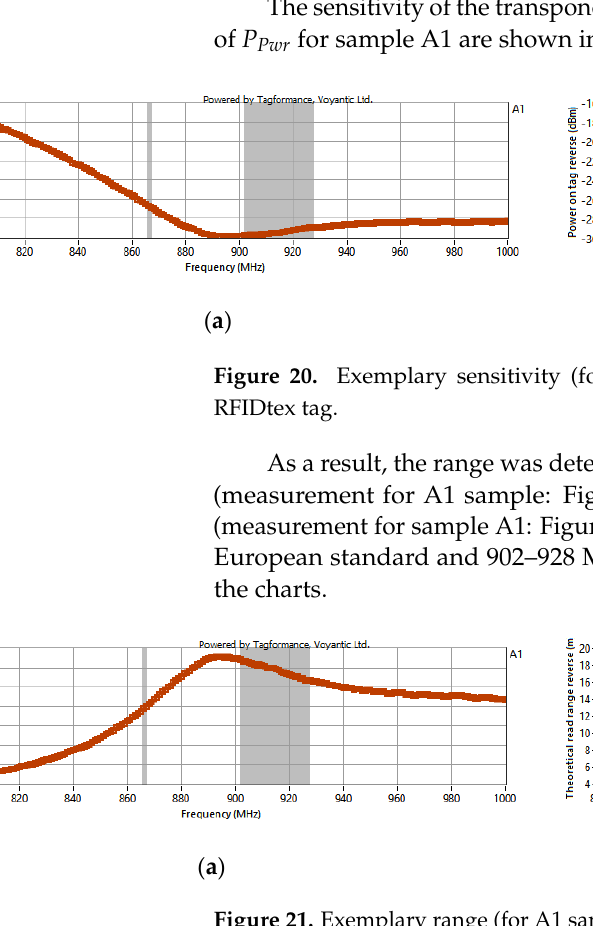
Measurements were repeated for all seven prepared demonstrators of the RFIDtex